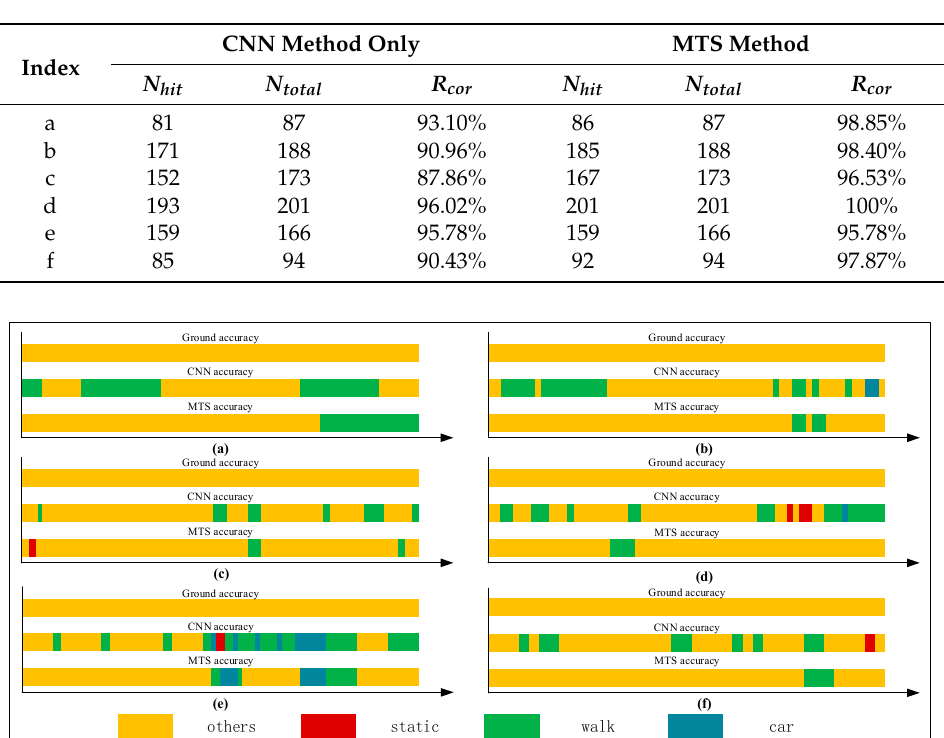
car Figure 13. Graphs showing recognition of the stationary state. Table 5. Recognition results for the walking state. Index